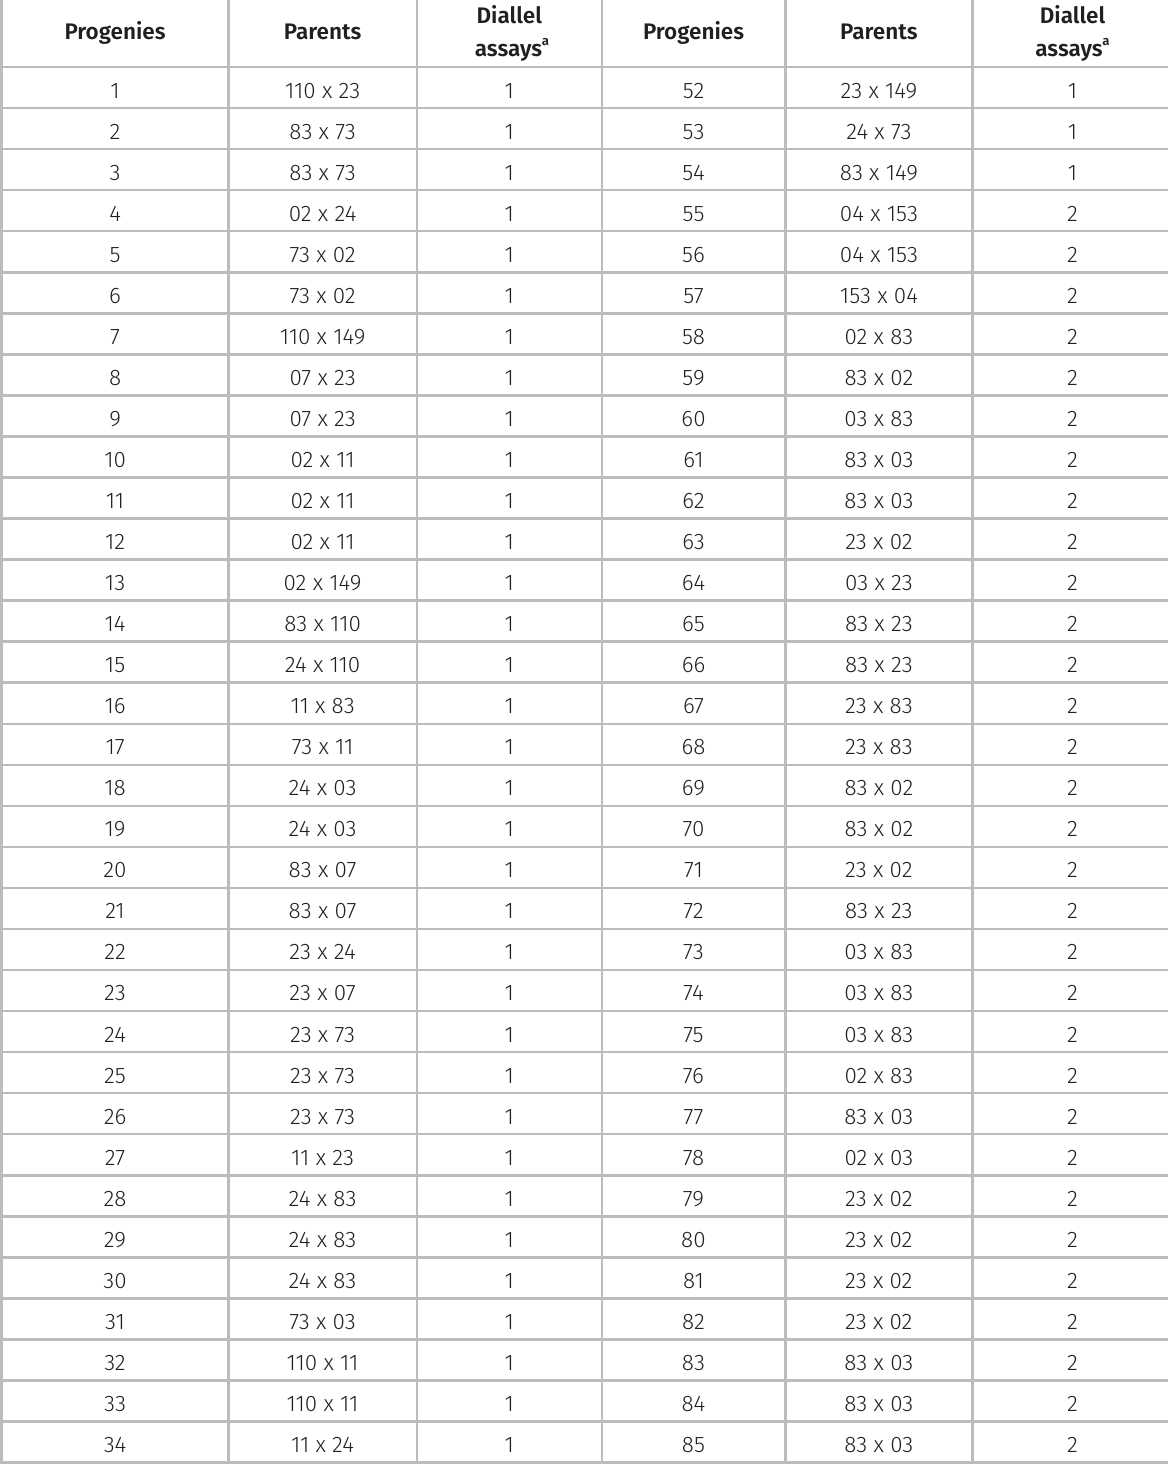
Table II. Relation of the 101 hybrid progenies obtained from diallel crosses involving eleven conilon coffee parents from the genetic breeding program of